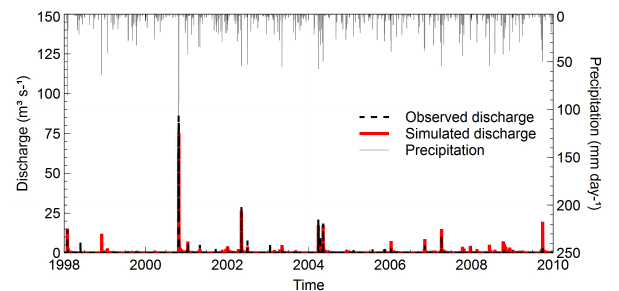
Fig. 6. Hydrological calibration (October 2000–October 2003) and validation (1998–2010) at daily resolution.